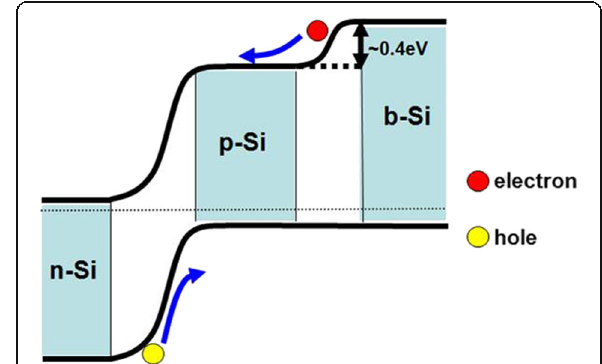
Fig. 5 Energy band diagram of the PN junction with b-Si at the rear